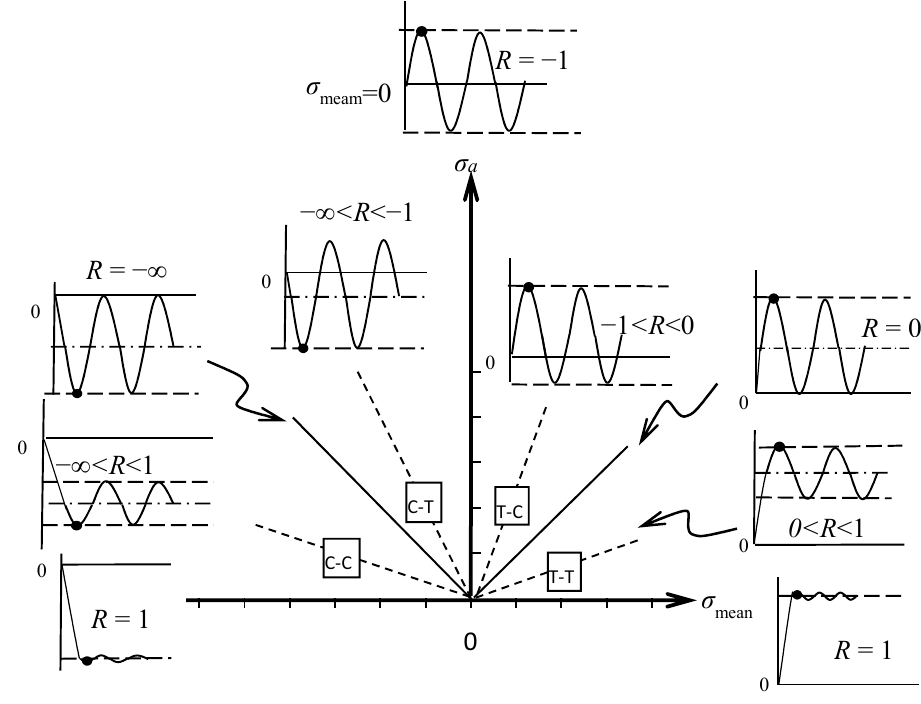
Figure 1. Stress ratio ranges on σ a – σ mean diagram for the loading types: T-T, T-C, C-T, and C-C. Representability of fatigue damage at failure applies to some of S-N curve models derived from the fatigue damage formulations. The damage accumulated during cycling ( D ) or damage at